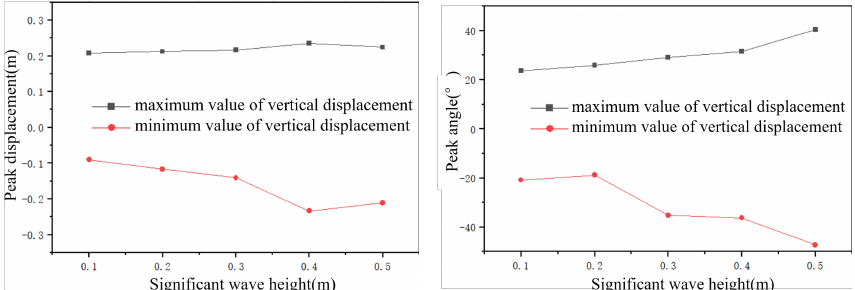
Figure 21. Curves of the maximum vertical displacement and pitch angle of the Shark-AUV versus the significant wave